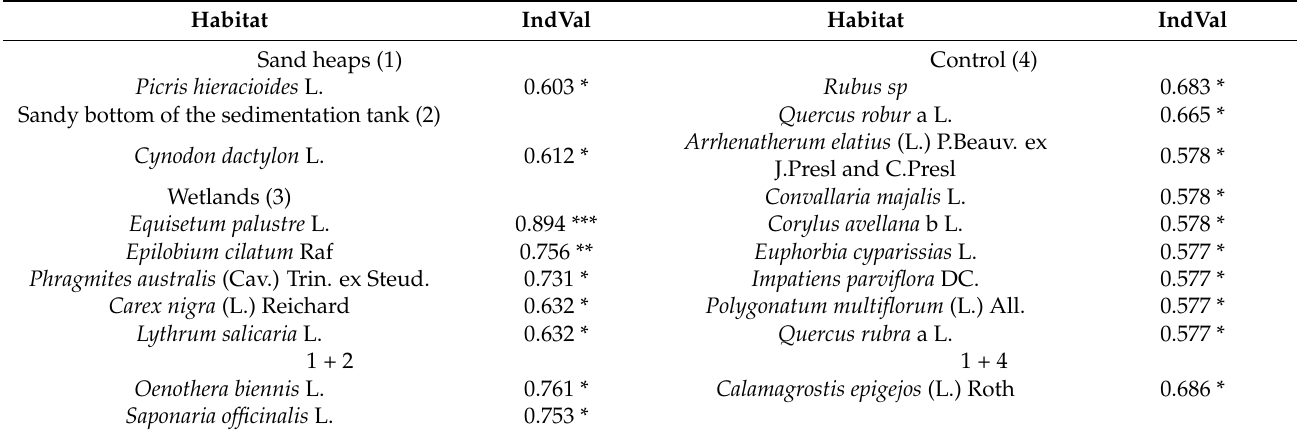
Table 1. The estimates of the indicator values of the species in a specific type of vegetation. *— p < 0.05; **— p < 0.01, ***— p < 0.001. Habitat IndVal Habitat IndVal Sand heaps (1) Control (4) Picris hieracioides L. 0.603 * Rubus sp Sandy bottom of the sedimentation tank (2) Quercus robur a L. Cynodon dactylon L.